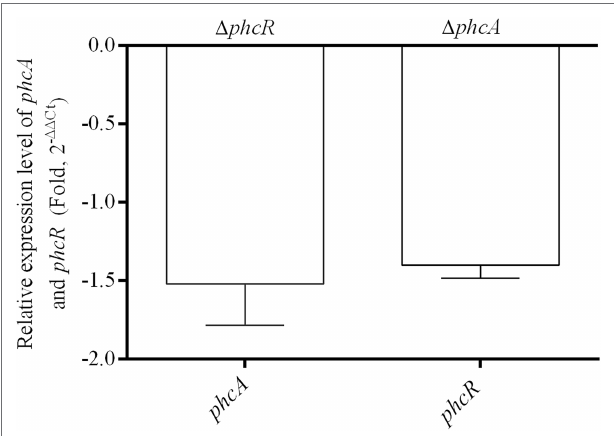
FIGURE 7 | qRT-PCR analysis of phcA and phcR gene expression in Δ phcR and Δ phcA mutant of strain EP1, respectively (OD 600 = 1.0). The Δ phcA and Δ phcR refers to deletion of phcA and phcR from wide type strain EP1, respectively. The results were calculated as 2 – ΔΔ Ct , – ΔΔ Ct = − ( Δ Ct mutant – Δ Ct wt ). Three biological repeats (independent cultures) and three technical repeats were done to calculate and compare the values, mean values of all experiments were averaged with SD (error bars) by using the GraphPad Prism 6.0